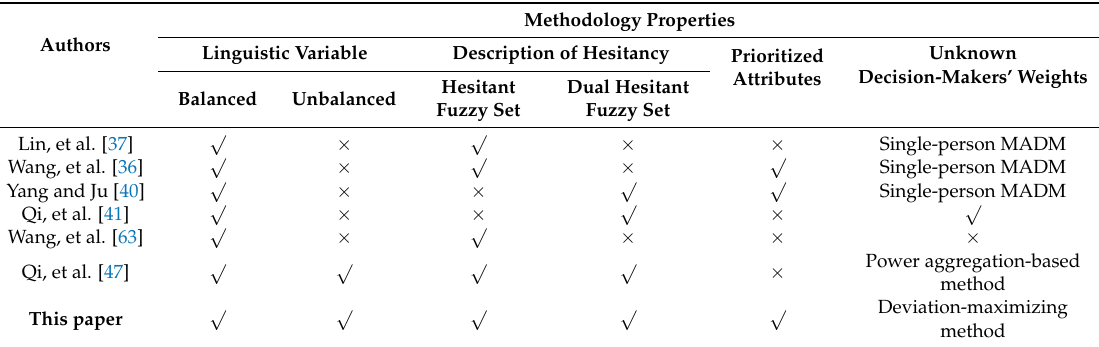
Table 1. Representative hesitant fuzzy linguistic MADM methods and their